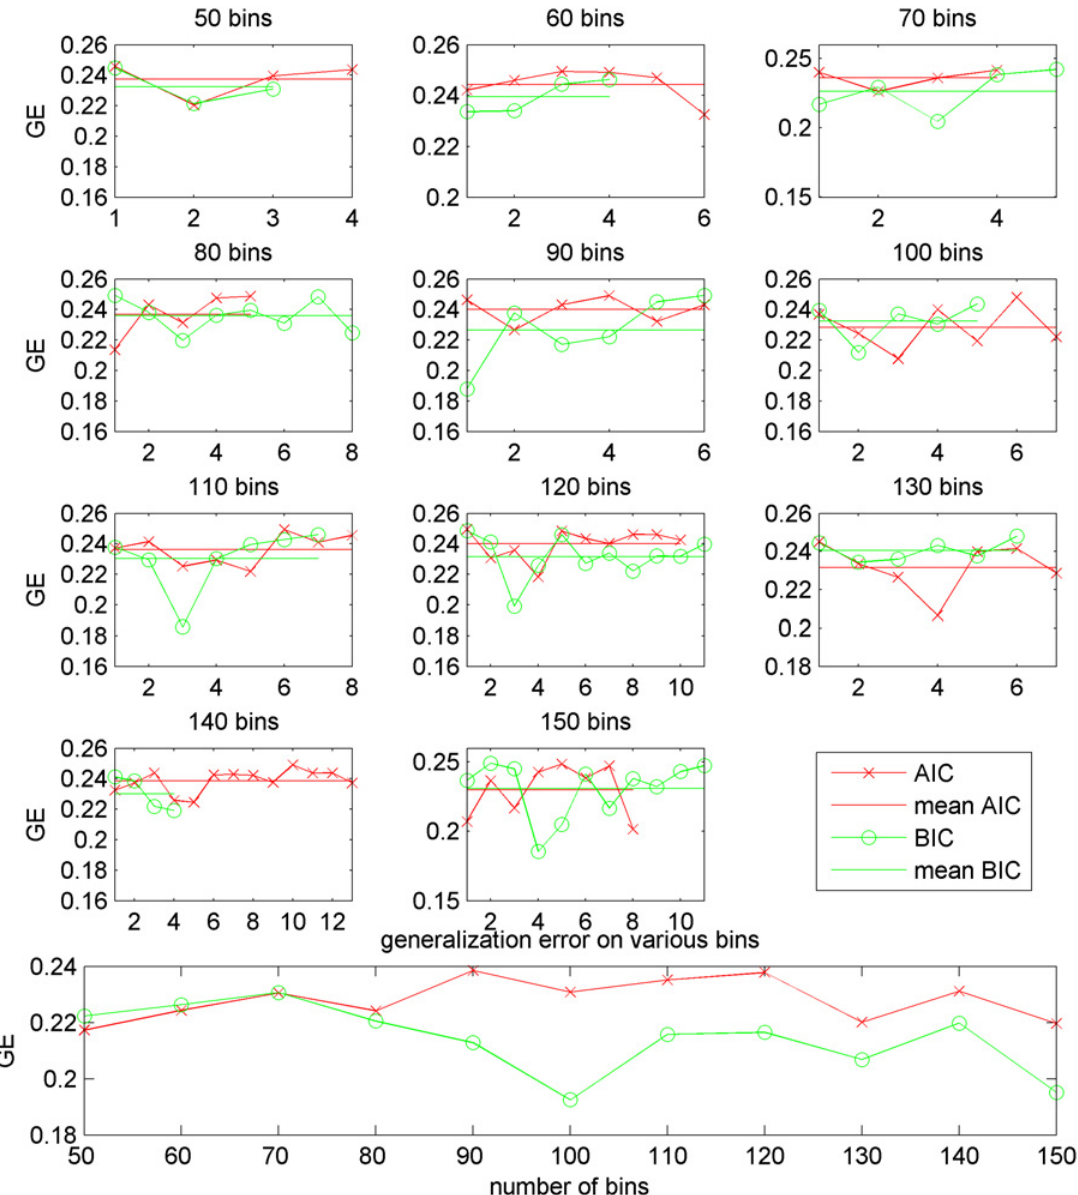
Fig 2. Generalization error (GE) by BIC and AIC using pSMC normalization of MCI versus AD on the ADNI dataset. The generalization error (equivalently, 1-accuracy) is computed based on features (mean and standard deviation value) extracted from the clusters in the individual bin (one bin among 50 bins, for example) via 10 times 10-fold cross-validation. For example, a green point can represent the classification GE using n- th bin when we divide the whole brain voxels into 50 bins. The plotted points are the bins that yield GE < 0.25, and these bins are highly predictive, thus contribute to the final classification results. The x-axis represents only the number of points, implying no ordering. The horizontal green line and red line are the mean values computed from green circles and red crosses, respectively. The bottom plot illustrates the generalization error from dividing brain voxels into 50 bins till 150 bins after collecting top informative features from the individual